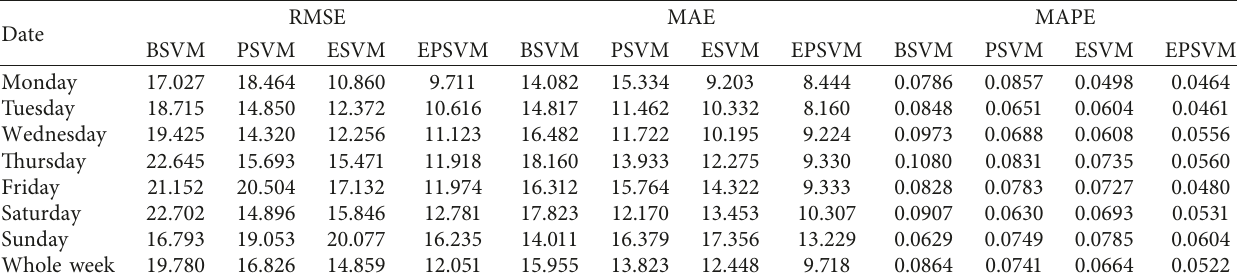
Table 2: The result of the three evaluation metrics of the four forecasting methods (outflow NTD). RMSE MAE Date